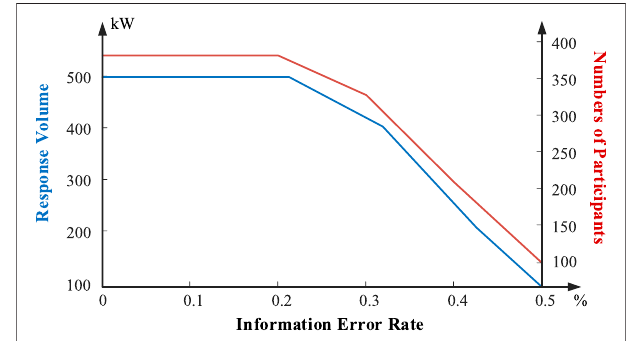
FIGURE 5 | Result distribution of different information error rates.